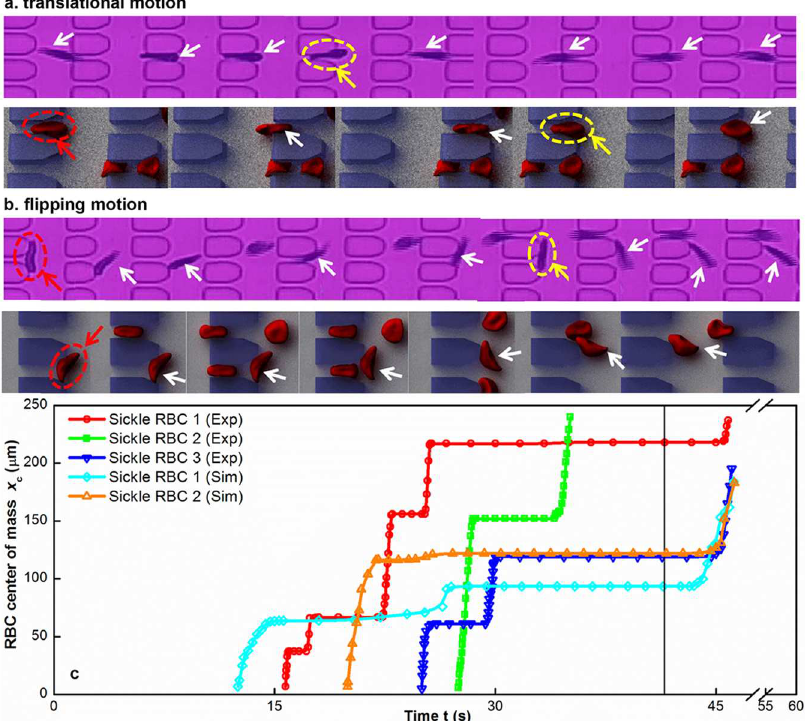
Fig 3. Direct observation of single-cell capillary obstruction. Four sequencesof video images of hypoxia- affected sickle RBCs (indicatedby white arrows) passing through microchannel constrictionsbefore they are obstructed at the microgates. These sickle RBCs have translational(a) and flipping(b) motion, leadingto parallel(a) or vertical (b) blockage,which may cause a transient (indicatedby yellow arrows) or persistent (indicated by red arrows) blockageto blood flow. (c) Individual trajectories of hypoxia-affected sickle RBCs passingthrough microchannel constrictions. Each line shows an individualtrajectory of a hypoxia-affected sickle RBC in microfluidic channel. The line segments, parallelto the horizontalaxis, indicatetransient or persistent (the topmost one, if any) occlusionscaused by trapped sickle